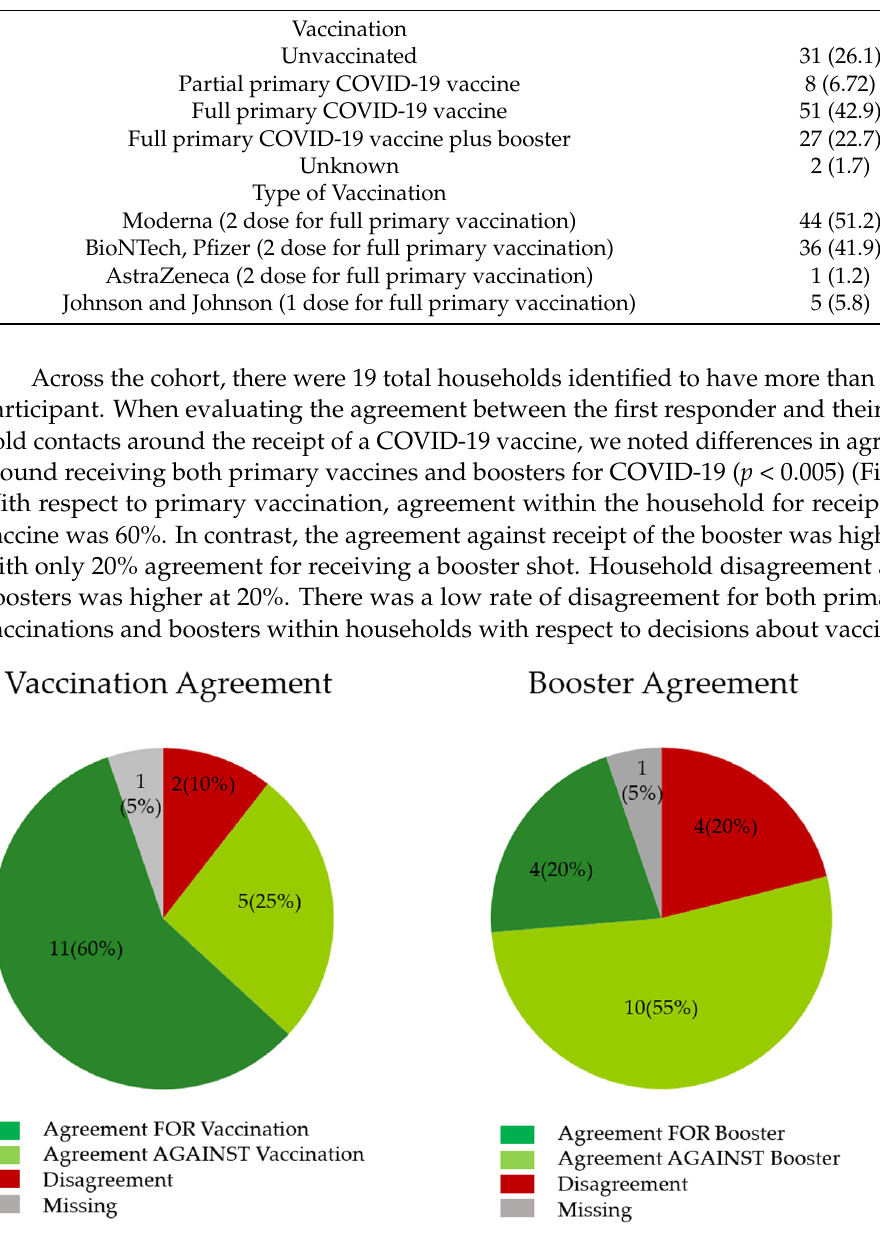
Figure 1. Agreement within households was different for receiving primary COVID-19 vaccinations and boosters ( p < 0.005). Agreement for primary vaccination was high (60%), whereas agreement for boosters was low (20%) within households.